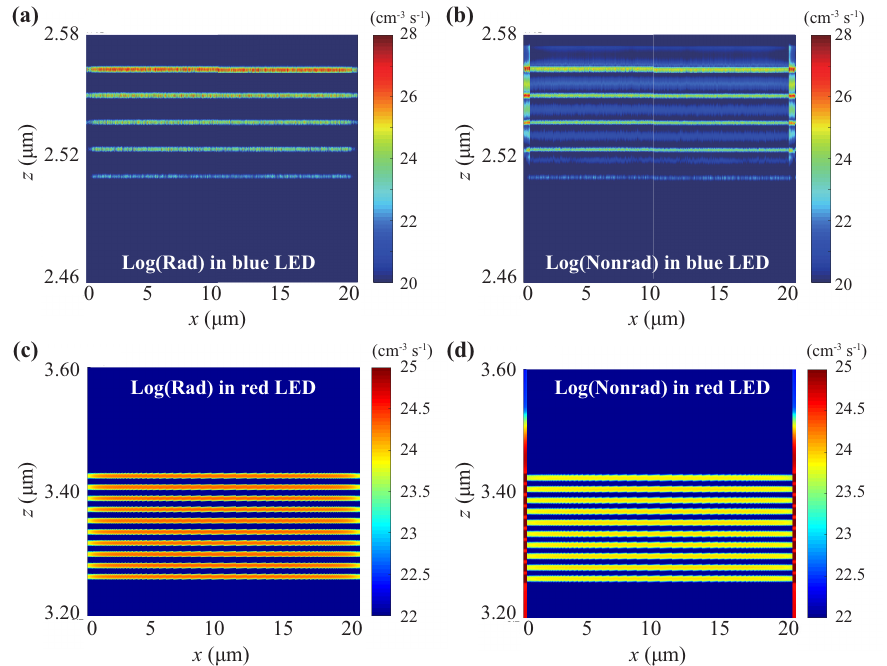
Figure 4. ( a , c ) Radiative and ( b , d ) non-radiative recombination rate (per unit volume per unit time) distributions at a current density of 20 A/cm 2 for the 20- µ m blue and red LEDs with piezoelectric effect and random alloy fluctuations.